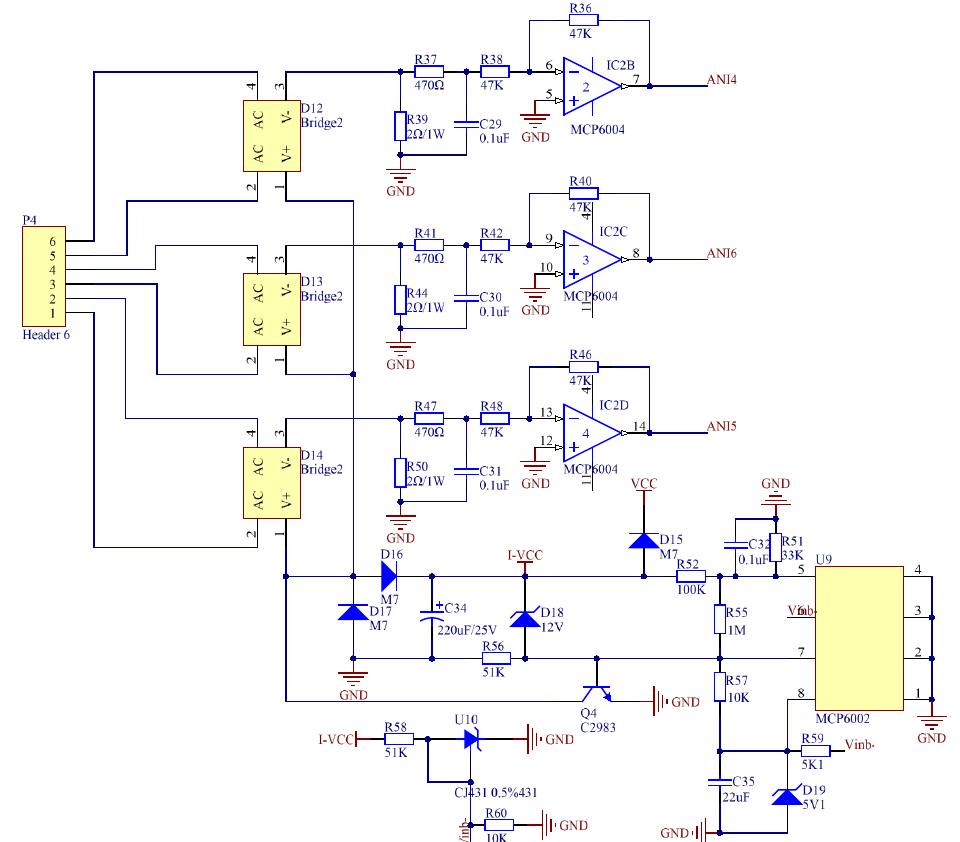
Figure 11. Current sampling and CT power circuit diagram.